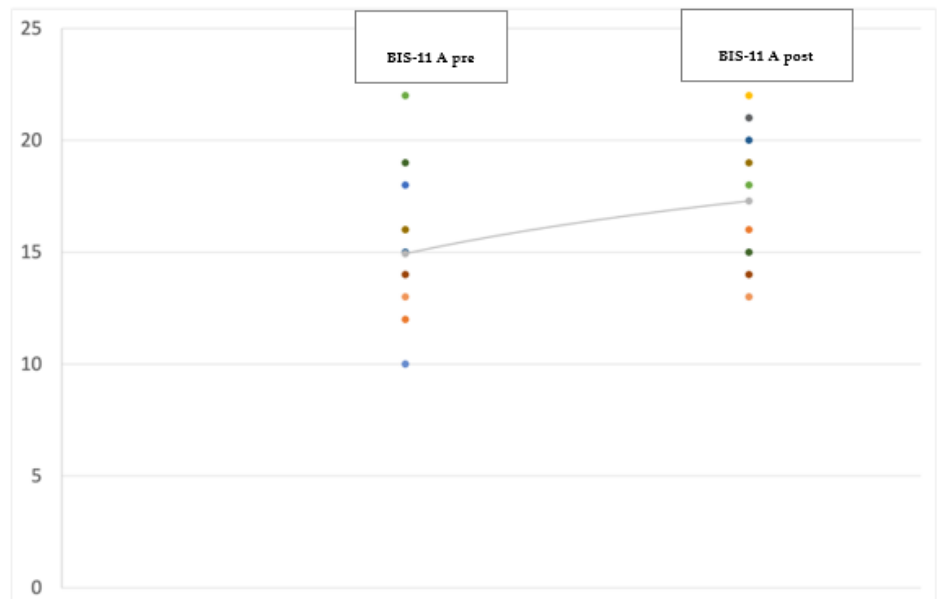
Figure 4. Jittered scattered plot showing the preoperative ( left ) and postoperative ( right ) Barratt Impulsiveness Scale-11 of the 14 patients in the study. The difference between the preoperative ONmed and postoperative ONstim showed a p -value = 0.048. The line shows the positive (worsening) trend of the values.